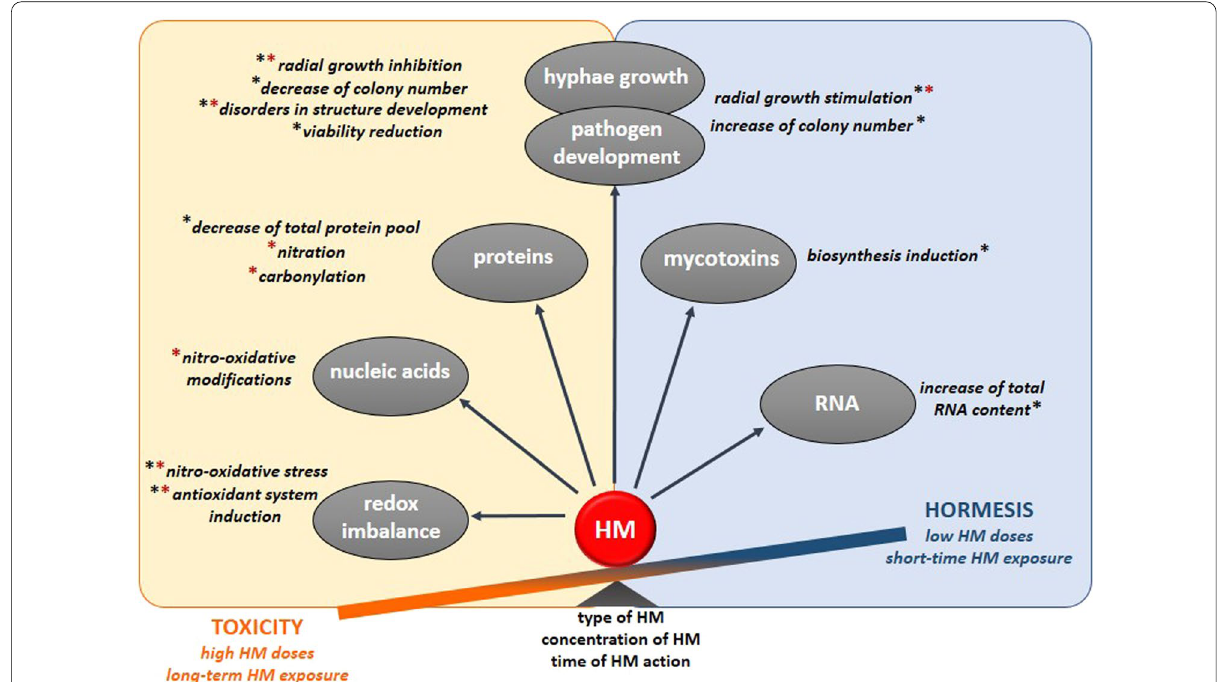
Fig. 3 A model summarizing the dual effects of pathogen exposure to HMs. Depending on the HM, its dose and exposure time, a toxic or hormesis‑like effects can be observed. Black asterisks indicate effects documented in fungi; red asterisks indicate effects documented in